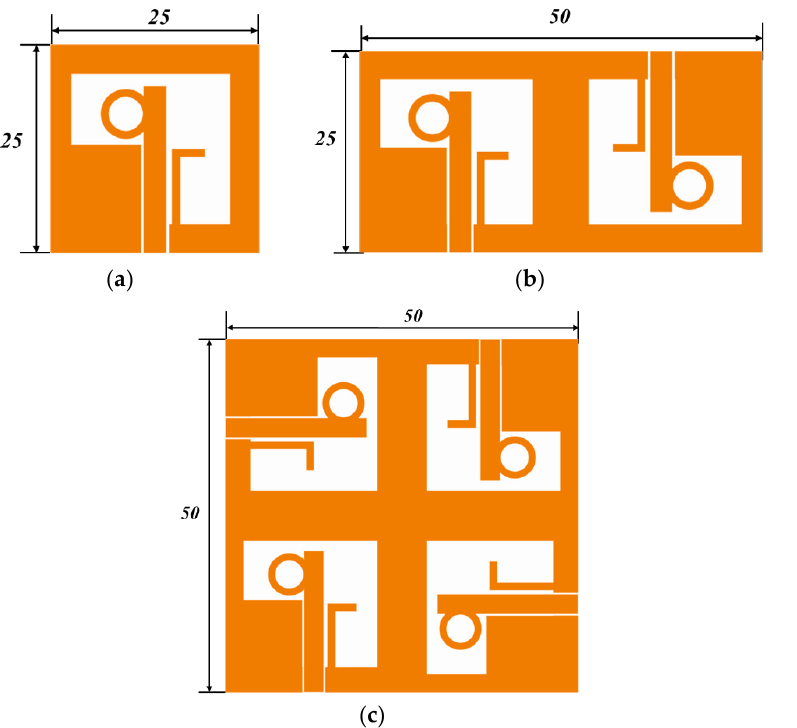
Figure 5. Design process of the quad-port CP-MIMO antenna ( a ) Ant @ 1, ( b ) Ant @ 2, and ( c ) Ant